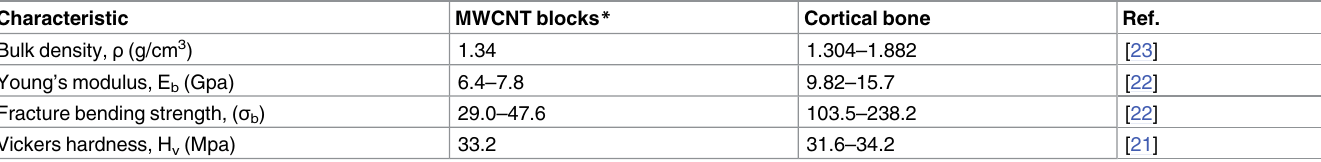
Table 1. A comparison of the mechanical characteristics of MWCNT blocks and cortical